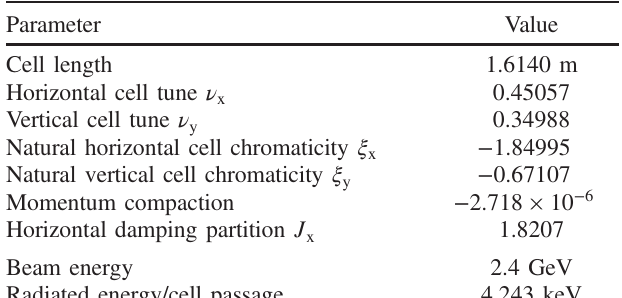
TABLE II. Lattice parameters of the Mathieu cell for the SLS 2.0 example as computed by OPA . Rounded values have been used where